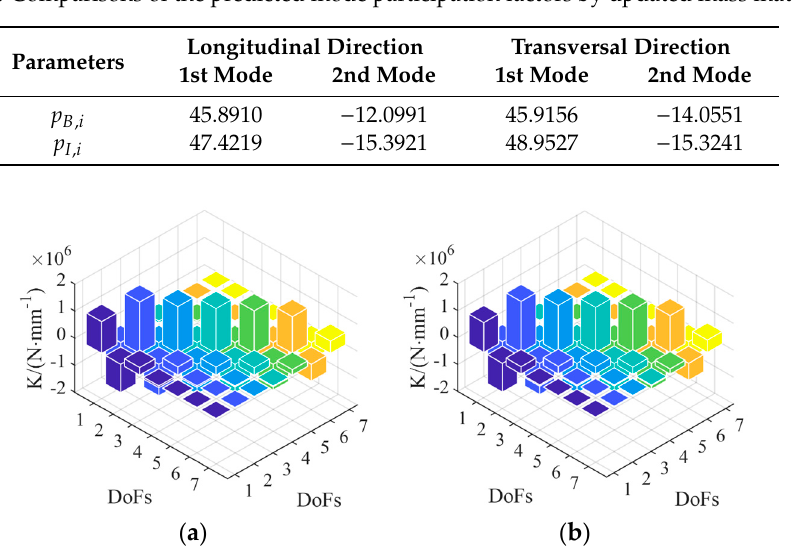
Figure 7. Updated stiffness matrices for the building itself: ( a ) Longitudinal direction; ( b ) Transversal